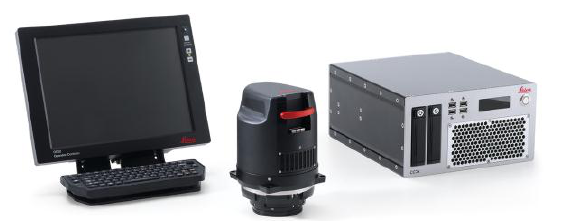
Figure 4. Leica RCD30 with OC52 Operator Control and CC32 Camera Controller with